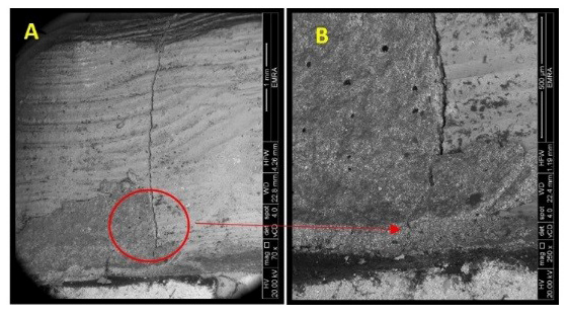
Figure 7. Mode of Failure III: SEM image revealed the crack extension through the finish line (A: 70X, B: 250X).